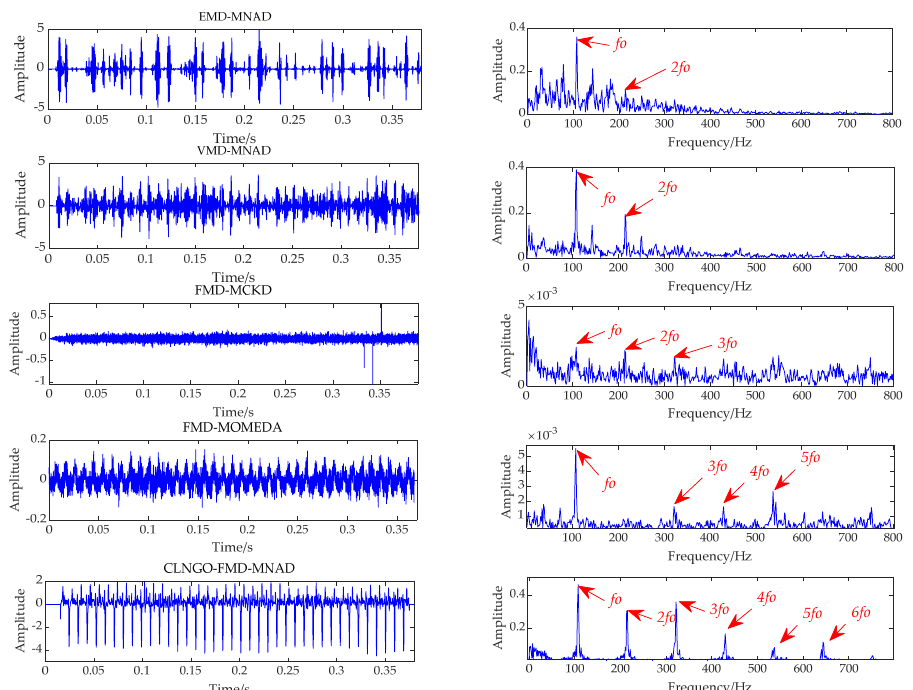
Figure 20. Comparing the results of different methods (outer fault